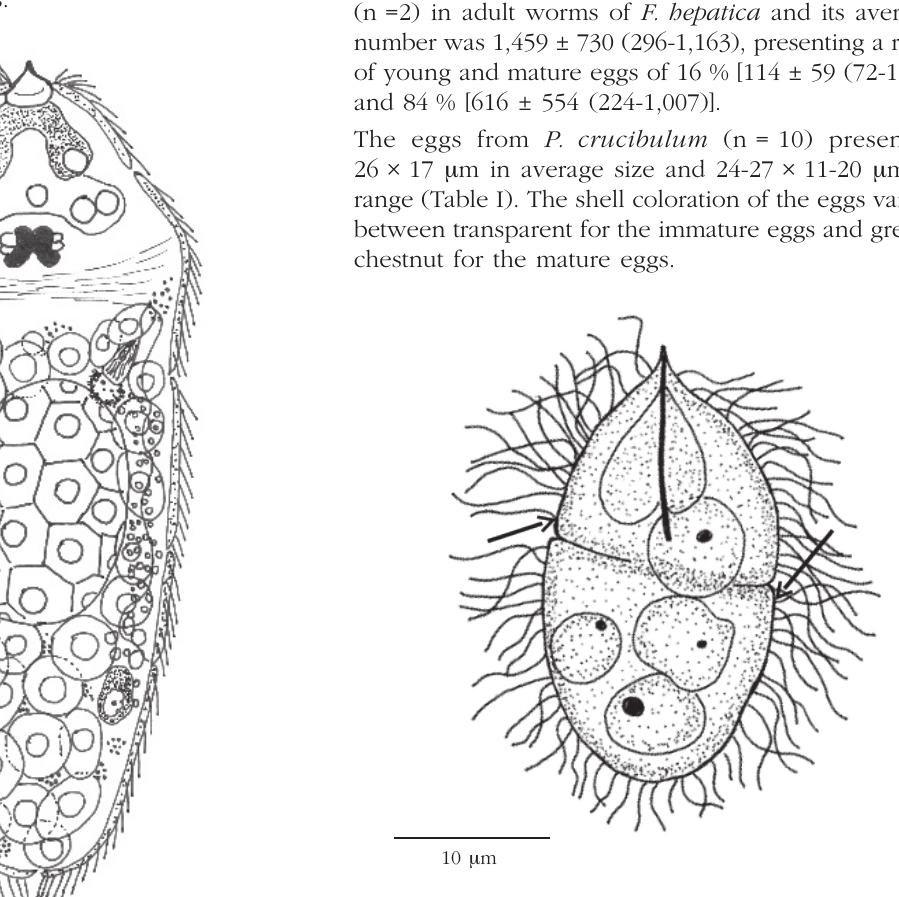
Fig. 2. – Drawing of a miracidium of Prosorhynchus crucibulum (Rudolphi, 1819) Odner, 1905, observed with light microscopy, covered with peripheral cilia and showing two epithelial plates (arrows) in the